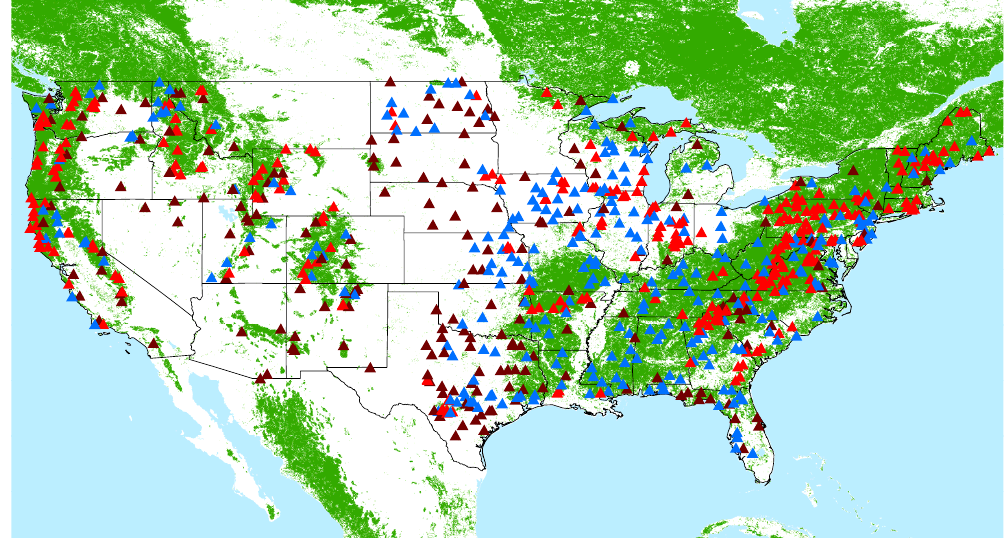
Fig. 9. All the 756 catchments mapped along with the forest cover within the United States: Group 1 (NS > 0.7; red), Group 2 (0.7 > NS > 0.3; blue), Group 3 (0.3 > NS;